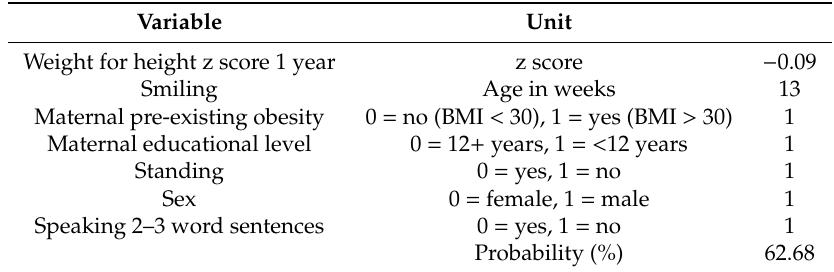
Table 4. Example of the use of the calculator in Excel format, using the developed prediction model for a hypothetical child as described in the results (“ Example